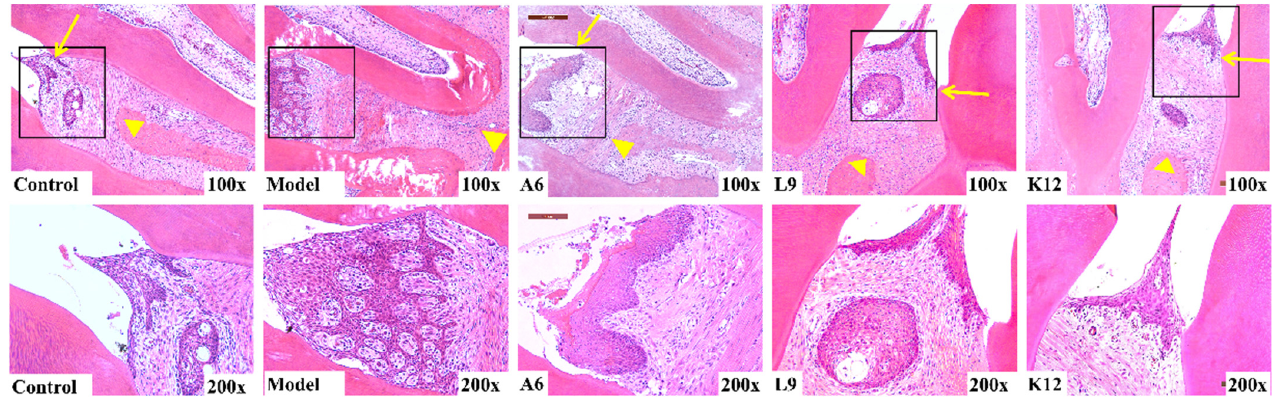
Figure 2. Effects of A6 or L9 administration on the histological changes in periodontal tissues in interproximal areas of the maxillary second molar (H&E staining, magnification, ×100 and ×200; yellow arrows represent CEJ, and yellow triangles represent ABC).